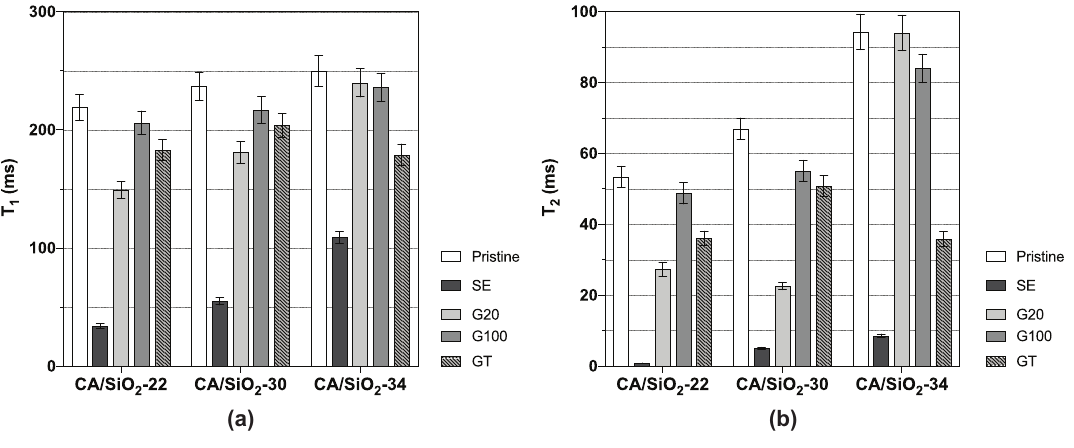
Figure 9. ( a ) Spin–lattice and ( b ) spin–spin relaxation times, T 1 and T 2 , respectively, of CA/ SiO 2